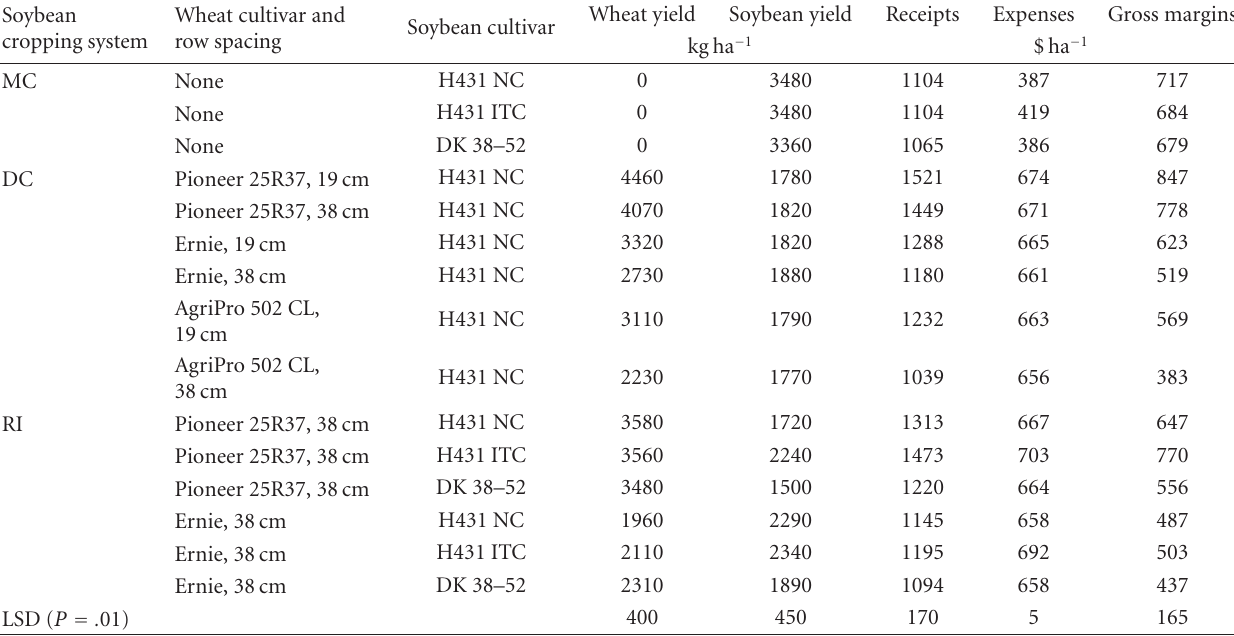
Table 8: Monocropped (MC), double-cropped (DC), and relay-intercropped (RI) system wheat yields, soybean yields, receipts, expenses, and gross margins. Data were averaged over years. Soybean Wheat cultivar and Wheat cropping system